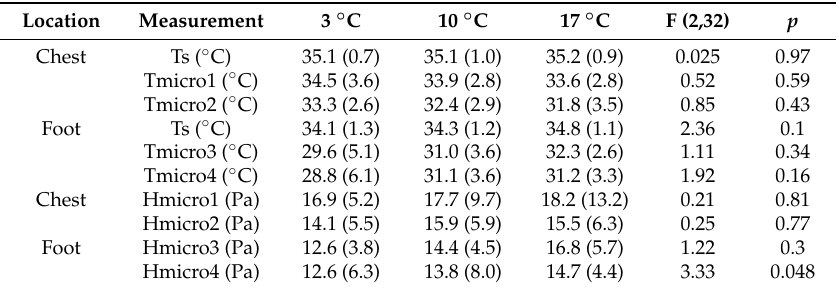
Table 3. Average (SD) of microclimate temperature and humidity at the chest and foot area during the sleeping